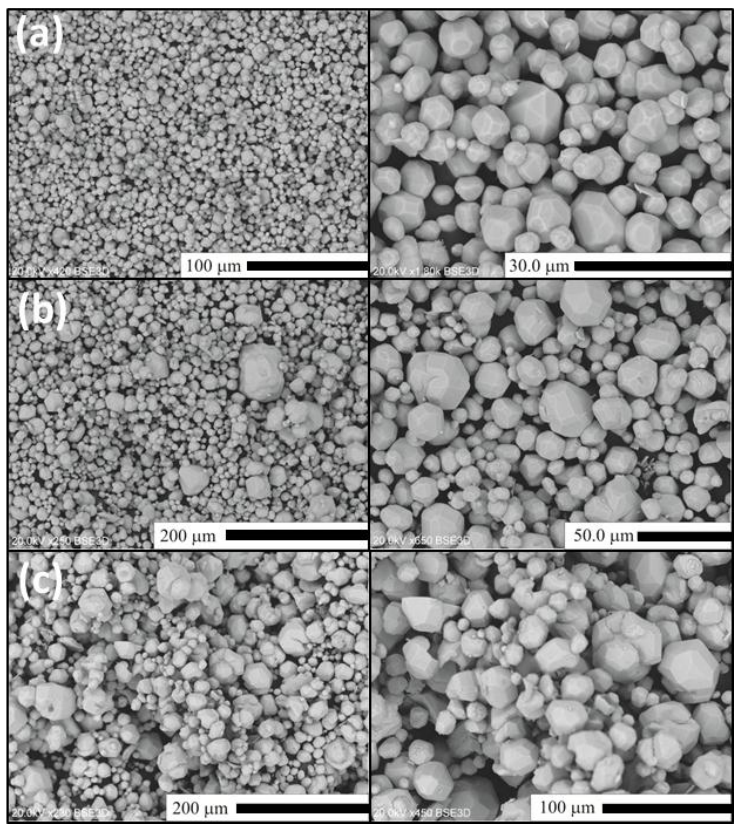
Figure 6. SEM images of Lu 2 O 3 :Eu of samples of Series IV. ( a ) SIV-1; ( b ) SIV-2; ( c )